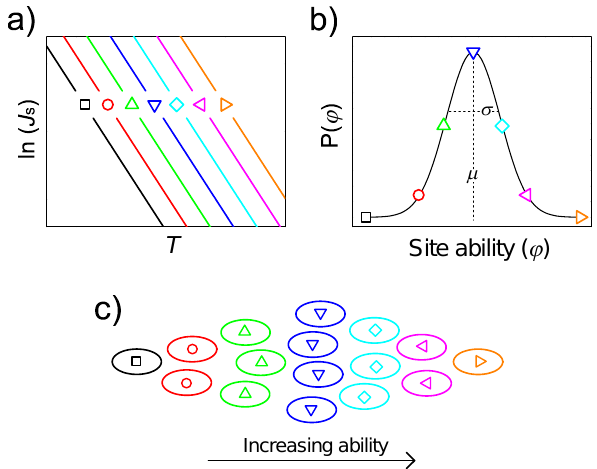
Figure 1. Principles of the multiple-component stochastic model. Each symbol represents a subpopulation approximated by a single- component system, as shown in (a) , with gradient − dln( J s,i )/d T = λ and intercept ϕ (proxy for nucleating efficiency). The probabil- ity of occurrence for each component, characterised by ϕ , is deter- mined using a statistical distribution, as depicted in (b) , with a mean µ and standard deviation σ . Applying this probability to a popula- tion of droplets results in an ensemble of droplets exhibiting a range of nucleating efficiencies as in (c)